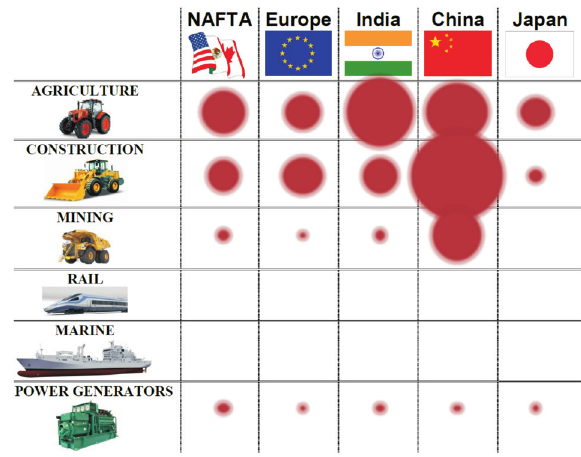
Fig. 1. The share of non-road engines in selected regions of the world [3] A recent increase in the sales of NRMM vehicles has been greater than that of heavy-duty vehicles (HDV) (Fig.